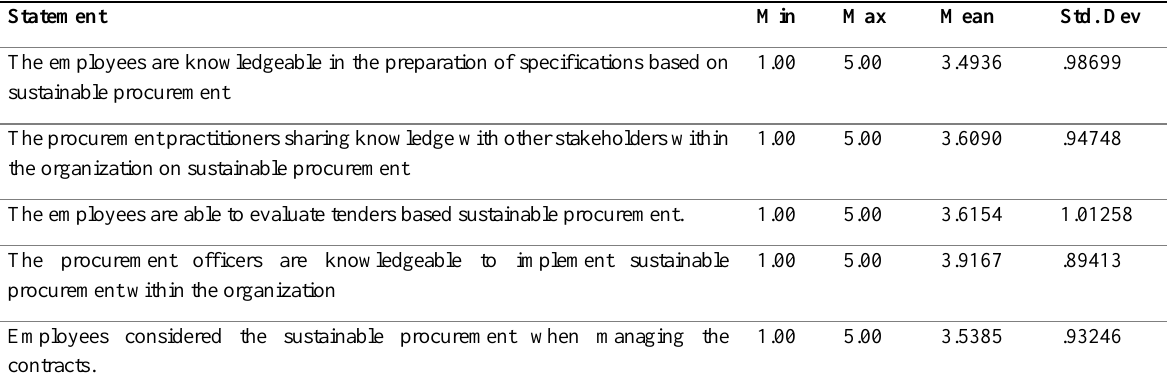
Table 6: Effect of Staff Competence on Sustainable Procurement